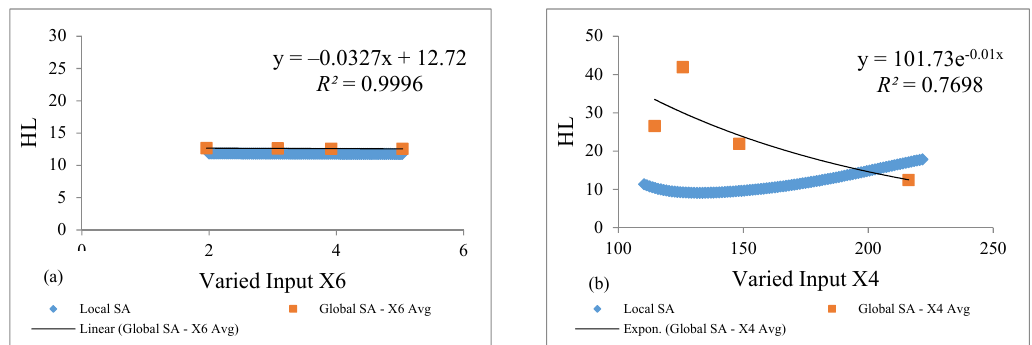
Figure 7. Network output (HL) for varied ( a ) orientation (X6) and ( b ) roof area (X4).